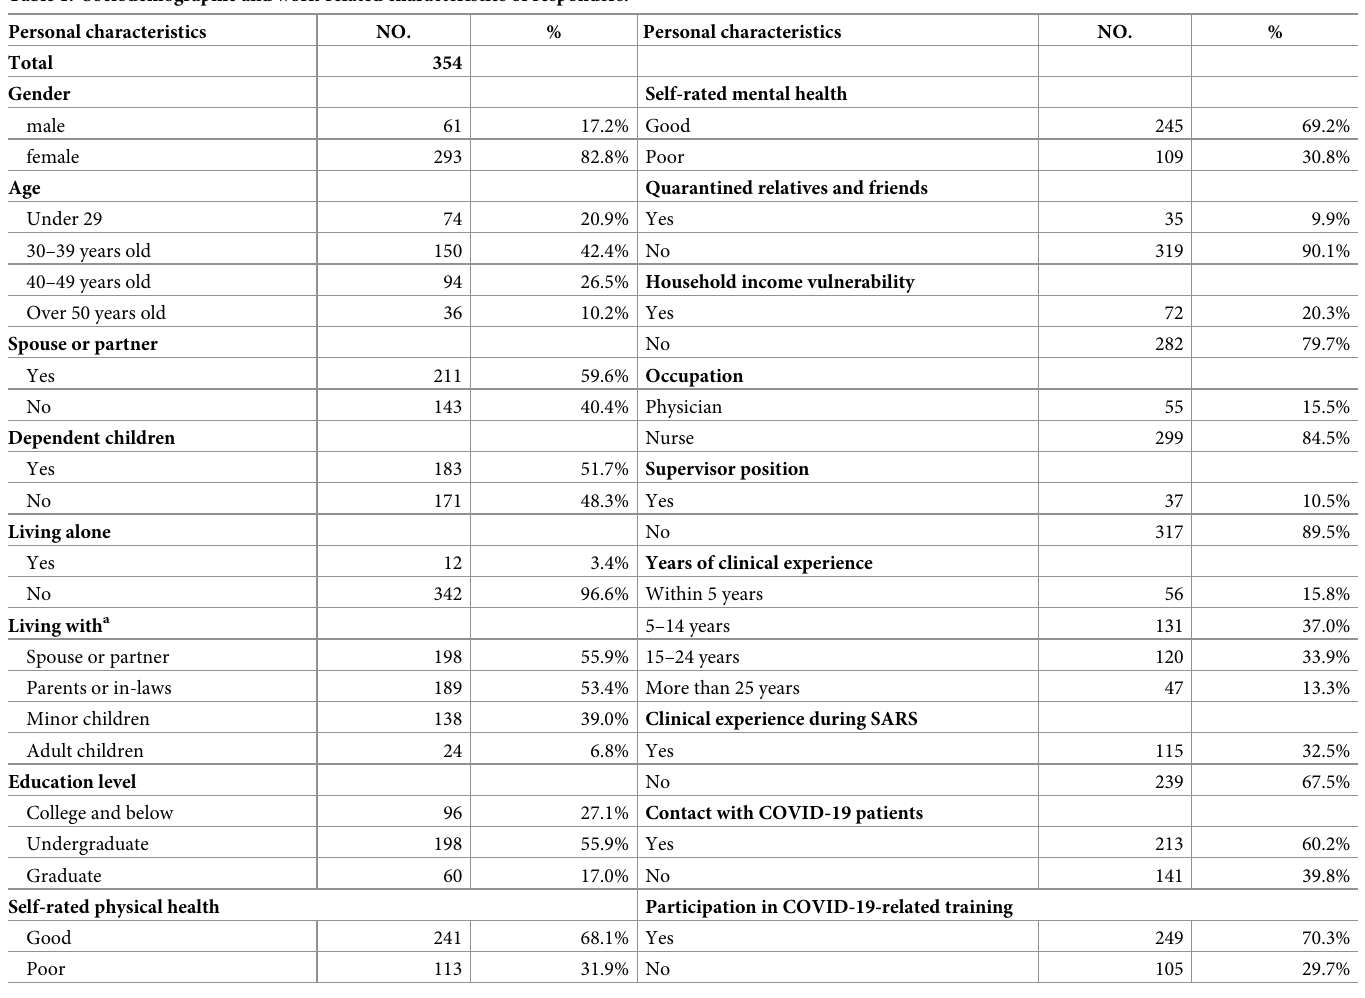
Table 1. Sociodemographic and work-related characteristics of